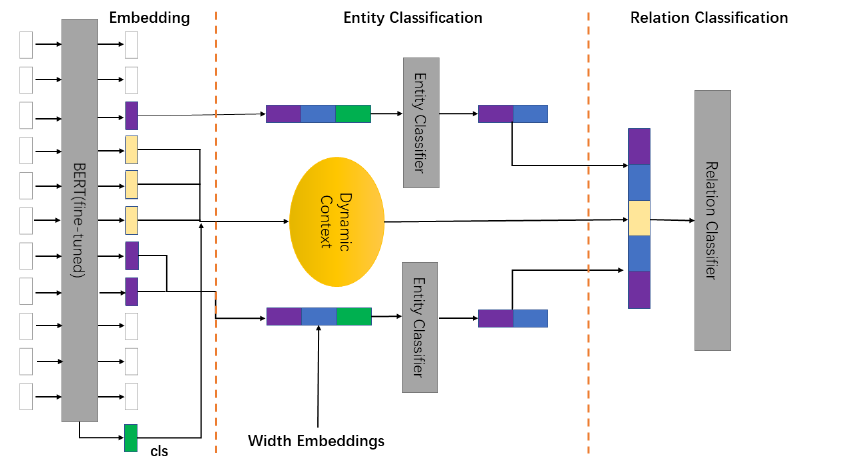
Figure 1. There are three sections: embedding, entity classification and relation classification. Then, all words are converted to token representation through BERT. All entities in the sentence are detected. All entity pairs fusing their dynamic context are classified into